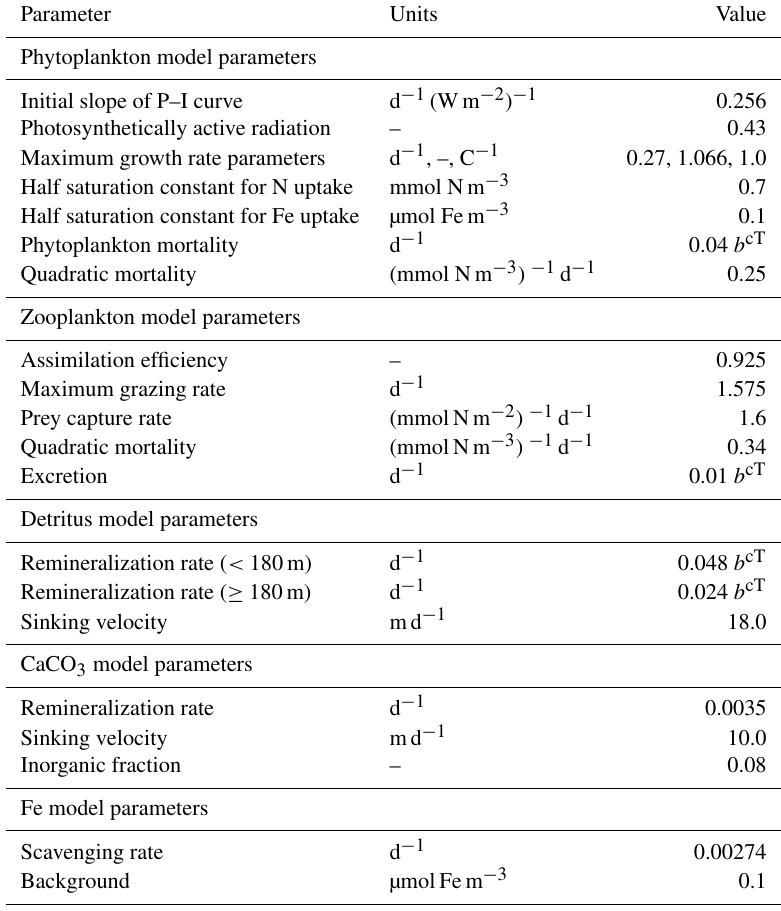
Table 1. Model Parameters of the BGC model were set to the values optimized in the one-dimensional (1-D) model of the Southern Ocean (Oschlies and Schartau,